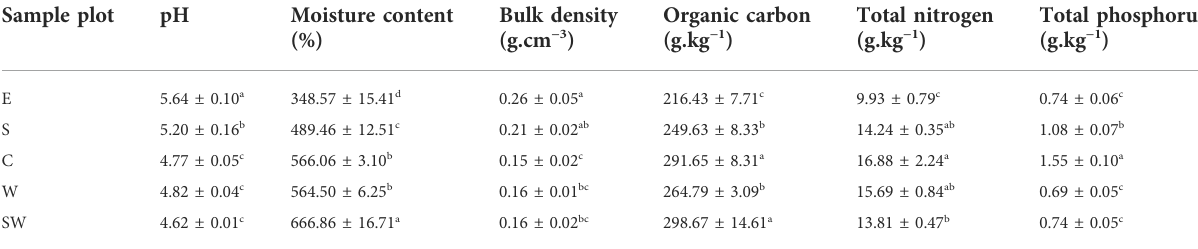
TABLE 1 Soil physicochemical properties in various sample plots. Sample